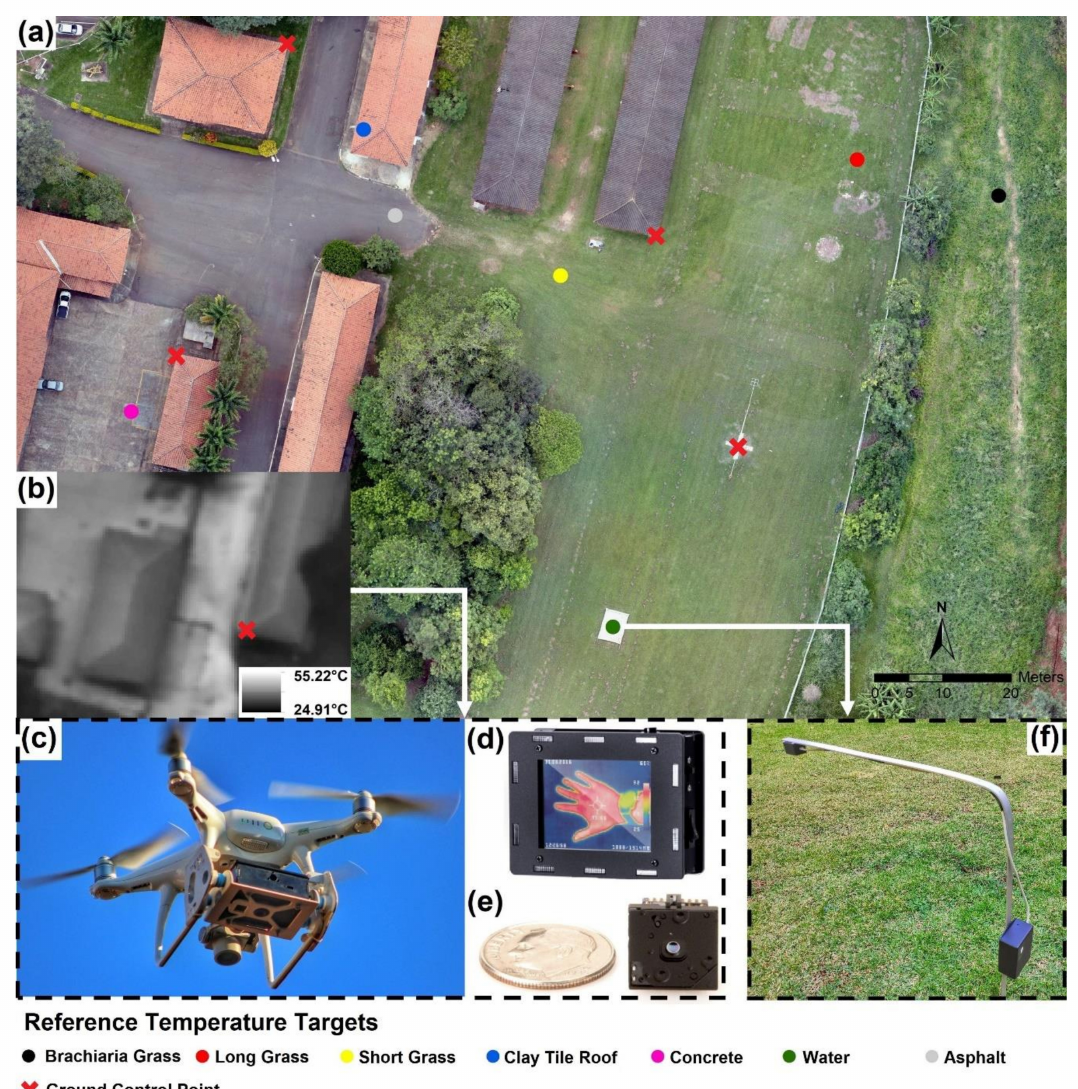
Figure 1. Data acquisition scheme for aerial analysis. ( a ) Distribution and types of reference targets and ground control points; ( b ) Thermal image snapshot; ( c ) UAV platform with the Lepton camera onboard; ( d ) Lepton camera; ( e ) FLIR Lepton 3.5 OEM sensor; ( f ) Ground reference temperature platform with the MLX90614